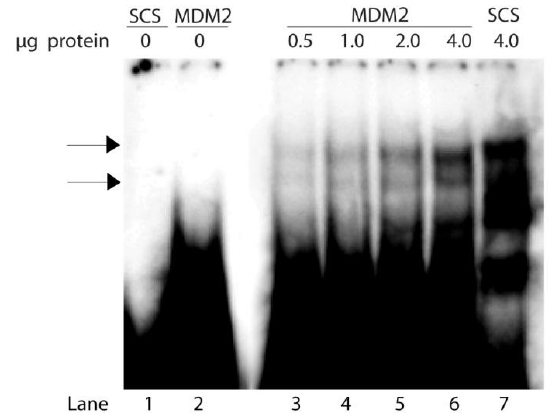
Figure 3. Increased binding of Scp53BSF to the natural p53 binding site from the MDM2 gene as a function of increasing quantities of protein. Concentration-dependent binding was examined using 0.45 pmole of radiolabeled MDM2 oligonucleotide and 0.5 to 4 μg of protein from the nuclear extracts. Lane 1: radiolabeled SCS oligonucleotide, no protein. Lane 2: radiolabeled MDM2 oligonucleotide, no protein. Lane 3-6: radiolabeled MDM2 oligonucleotide with 0.5 μg (lane 3), 1 μg (lane 4), 2 μg (lane 5) and 4 μg (lane 6) of protein. Lane 7: radiolabeled SCS oligonucleotide with 4 μg of protein.